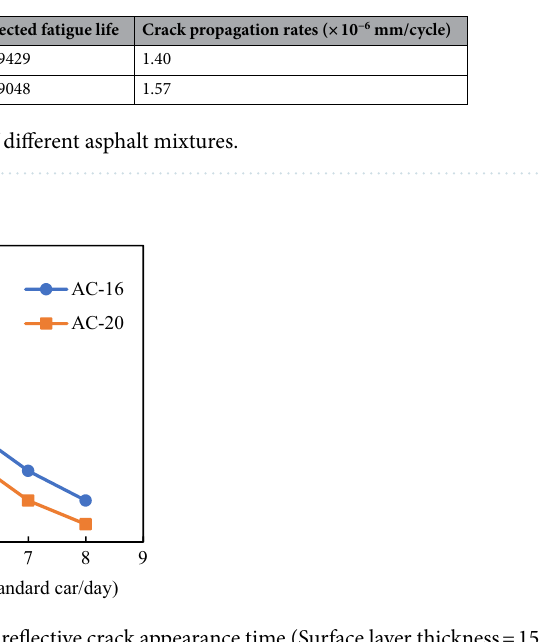
Figure 19. Traffic volume and reflective crack appearance time (Surface layer thickness = 15